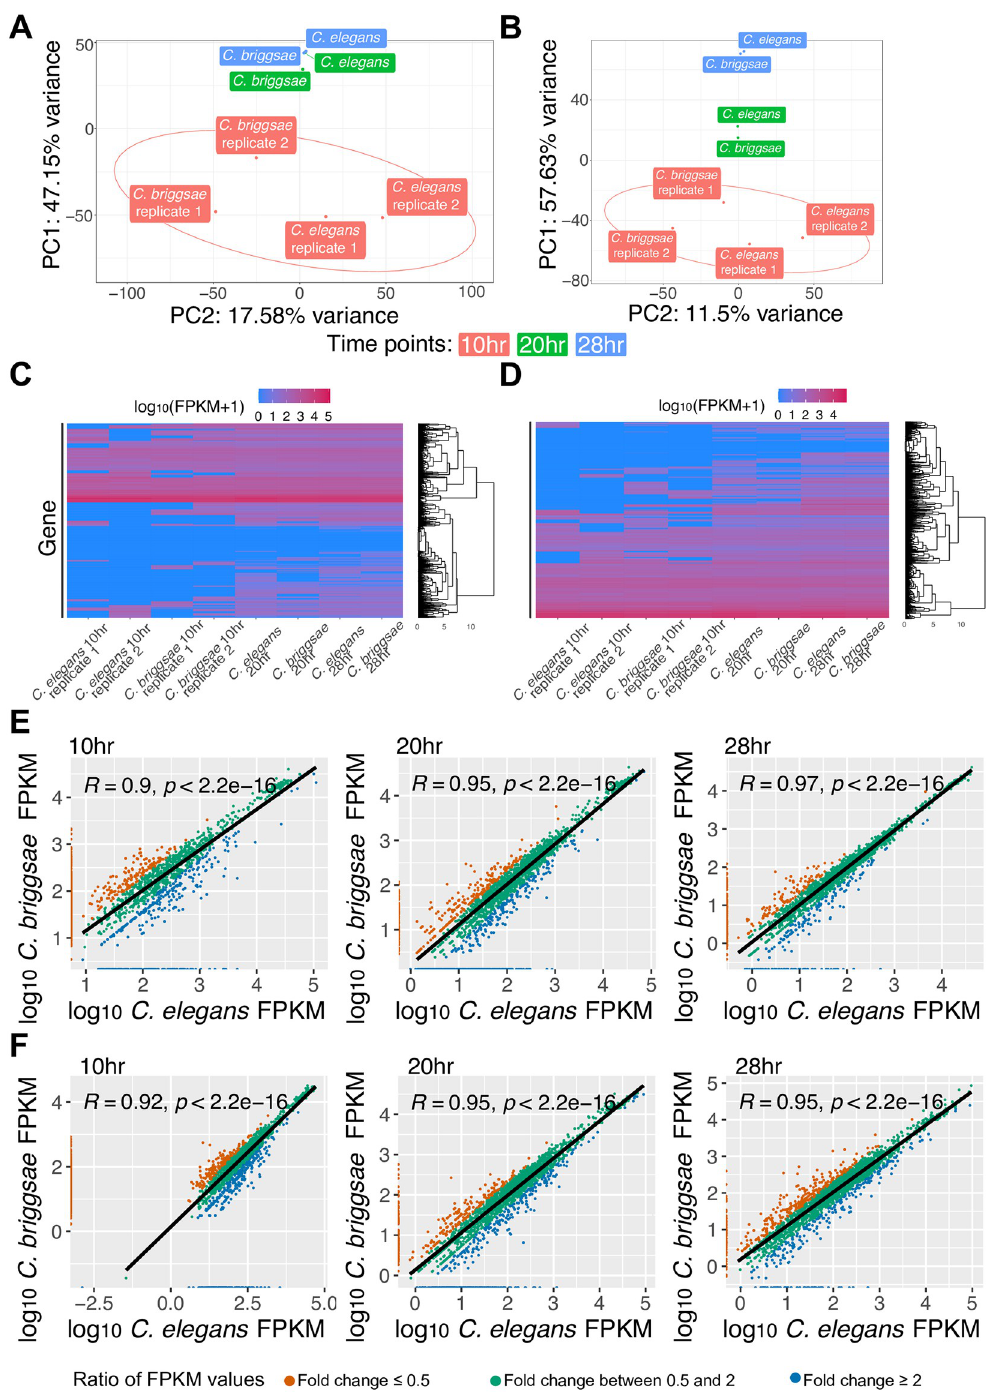
Fig 3. Nematocida gene expression in different host species. Principal component analysis of (A) N . parisii and (B) N . ausubeli in C . elegans and C . briggsae at 10, 20 and 28 hours. Circles represent confidence ellipses around each strain at 95% confidence interval. (C-D) Heatmap of transcriptional profiles of genes expressed in N . parisii (C) and N . ausubeli (D). Rows represent gene clustered hierarchically. Scale is of differential regulation of infected compared to uninfected samples. (E-F) Scatterplot of log10 FPKM values in N . parisii (E) and N . ausubeli (F) when infecting C . briggsae and C . elegans . Each point represents a microsporidian gene. Pearson correlation value and p-value are indicated on the top left of each plot. The ratio of FPKM values for each gene between C . elegans and C . briggsae is demonstrated by the colour of the points, which is described in the legend at the